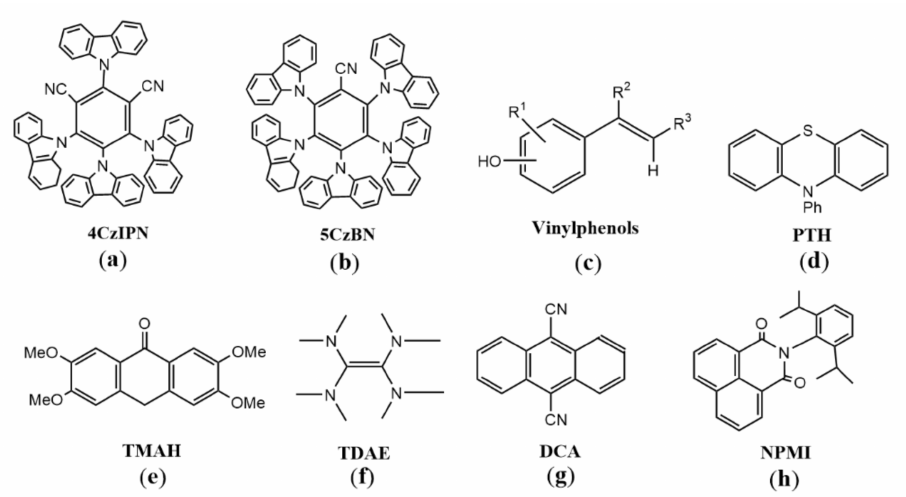
Figure 9. Organic photocatalysts involving single-photon excitation. ( a ) 4CzIPN: 1, 2, 3, 5-tetrakis (carbazol-9-yl)-4, 6-dicyanobenzene; ( b ) 5CzBN: carbazolyl cyanophenyl; ( c ) Vinylphenols; ( d ) PTH: N -phenylphenothiazine; ( e ) TMAH: 2, 3, 6, 7-tetramethoxyanthrone; ( f ) TDAE: tetramine (dimethy- lamine) ethylene; ( g ) DCA: 9, 10-dicyano-anthracene; ( h ) NPMI: 1,